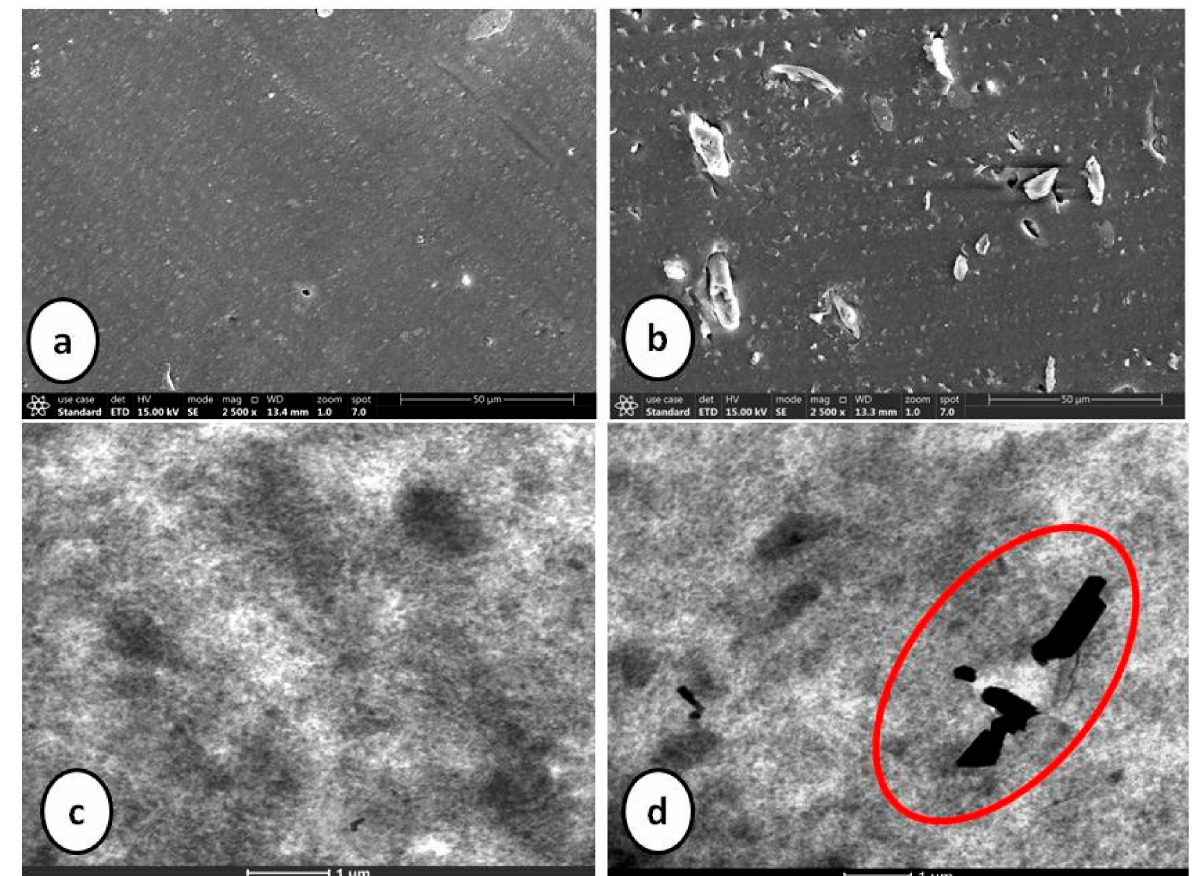
Figure 8. SEM ( a , b ) and TEM ( c , d ) images of silica-filled control and experimental